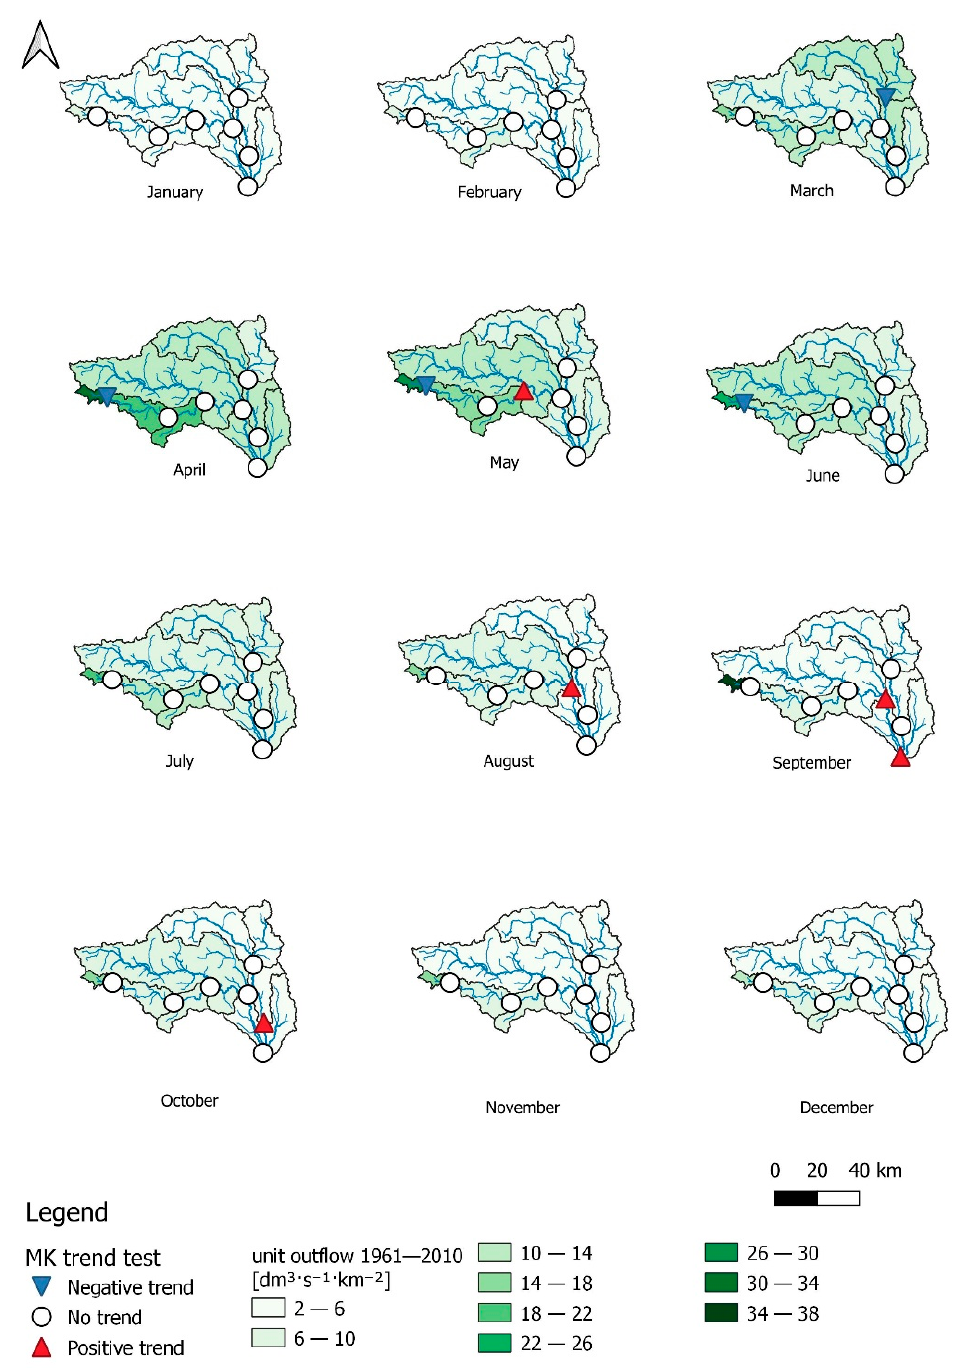
Figure 8. Monthly trends in flow during the years 1961–2010.